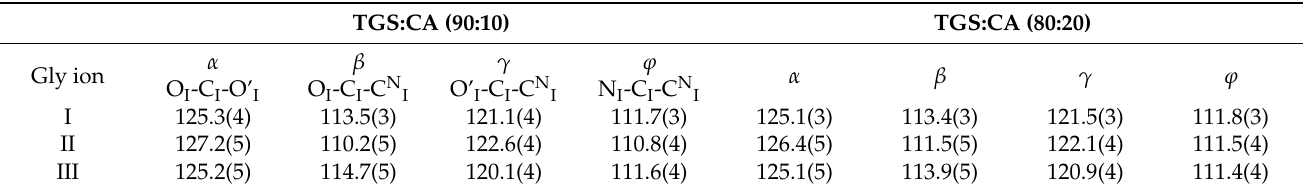
Figure 2. ( a ) TSG:CA (90:10) and ( b ) CA crystal structures. For TSG:CA structure ( a ) see space group and unit cell parameters in Table 1. The sizes of the voids in the TSG-like structure are ~0.6 × 1.1 nm. CA crystal structure ( b ) is characterized by the space group Pca 2 1 (29) and unit cell parameters a = 8.7108 Å, b = 5.1683 Å, c = 10.9562 Å [37]. The maximum size of CA molecules is ~0.5 nm. Table 2. Bond angles of Gly ions GlyI, GlyIII and GlyII in TGS:CA (90:10) and TGS:CA (80:20) structures obtained using single-crystal XRD